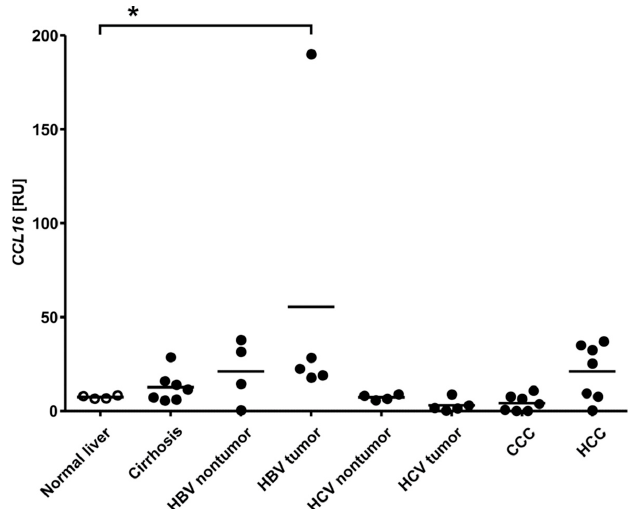
Figure 2. CCL16 expression in the liver occurs homeostatically. CCL16 mRNA was quantified in normal human liver tissue ( n = 4) in comparison to livers with cirrhosis ( n = 7), hepatitis B virus (HBV) and hepatitis C virus (HCV) infection ( n = 4–5), as well as cholangiocarcinoma (CCC; n = 7) and hepatocellular carcinoma (HCC; n = 7). Values are expressed as relative units (RU) normalised to 18S. Measurements of individual samples and the mean of each group are shown. A Mann–Whitney U test was performed to assess statistical significance (*, p < 0.05).